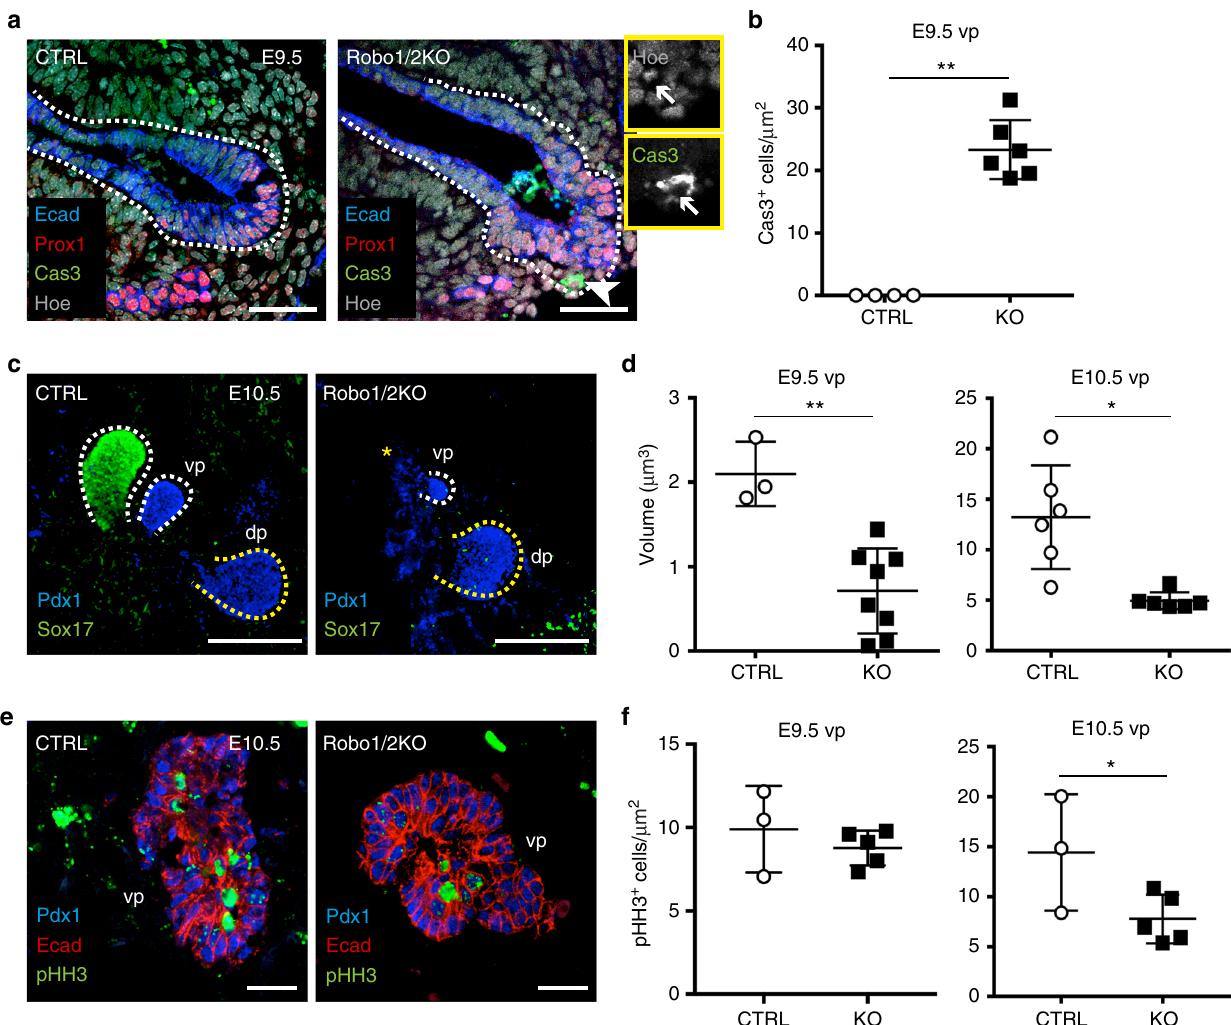
Fig. 3 Robo receptors are required for cell survival and proliferation of ventral pancreatic progenitors. a Representative IF images of E9.5 CTRL and Robo1/2 KO cryosections stained for Ecad, Prox1 and cleaved-Caspase3 (Cas3). Hoechst (Hoe) nuclear counterstain. Arrowhead indicates apoptotic nucleus; in yellow insets are shown Hoechst and Cas3 single channels. Scale bars, 50 µ m. b Quanti fi cation of Cas3 + cells in ventral pancreata of E9.5 CTRL ( n = 4) and Robo1/2 KO ( n = 6) embryos. Number of Cas3 + cells was normalised to the sum of the pancreatic Ecad + epithelial areas ( μ m 2 ). c Representative confocal maximum intensity z -projections of whole-mount IF for Pdx1 and Sox17 α on E10.5 CTRL and Robo1/2 KO embryos. White dashed line marks ventral pancreatic bud; yellow dashed line marks dorsal pancreatic buds. Absence of Sox17 + ventral pancreatic bud in KO embryo is indicated by yellow asterisk (*). Scale bars, 50 µ m. d Quanti fi cation of E9.5 and E10.5 ventral pancreas volume from confocal images of CTRL and Robo1/2 KO embryos. e Representative IF images of E10.5 CTRL and Robo1/2 KO cryosections stained for Pdx1, phospho-Histone H3 (pHH3) and Ecad. Scale bars, 50 µ m. dp dorsal pancreas, vp ventral pancreas. f Quanti fi cation of proliferation in ventral pancreatic buds of E9.5 and E10.5 CTRL and Robo1/2 KO cryosections. Number of pHH3 + cells was normalised to the sum of the Ecad + epithelium area ( µ m 2 ). Error bars represent ±s.e.m. Two-tailed Student ’ s t -test * P <0.05, ** P <